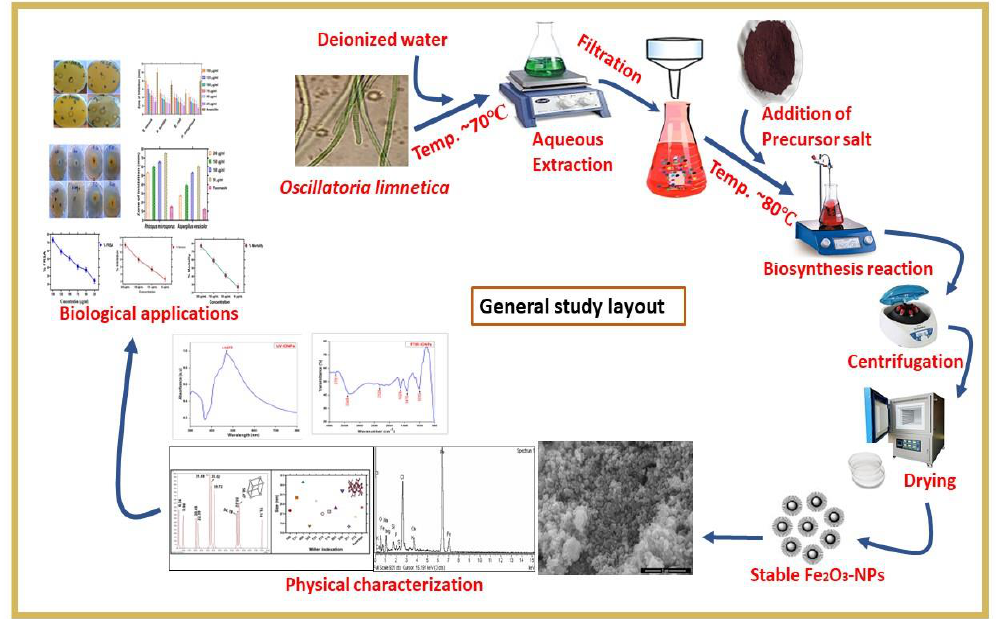
Figure 12. Detailed diagram showing green synthesis, characterization, and diverse biological application of IONPs.